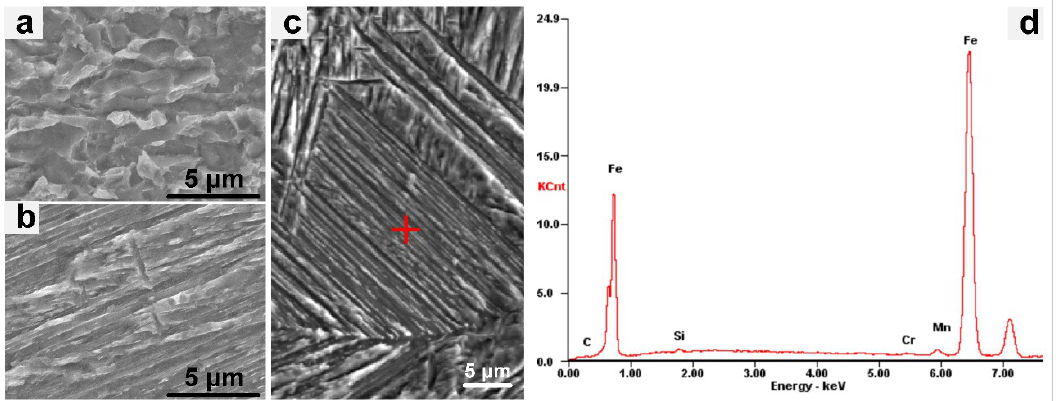
Figure 7. ( a – c ) X100 characteristic microstructures (SEM) of the laser-welded joint and ( d ) the energy spectrum of bainitic ferrite (BF).